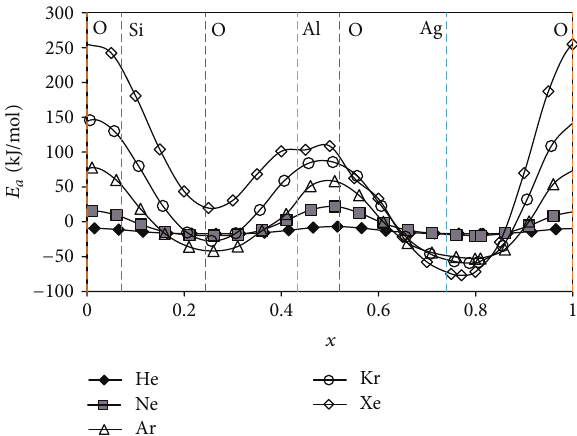
Table 2: Lattice parameters and bond lengths of silver aluminosili- cate.